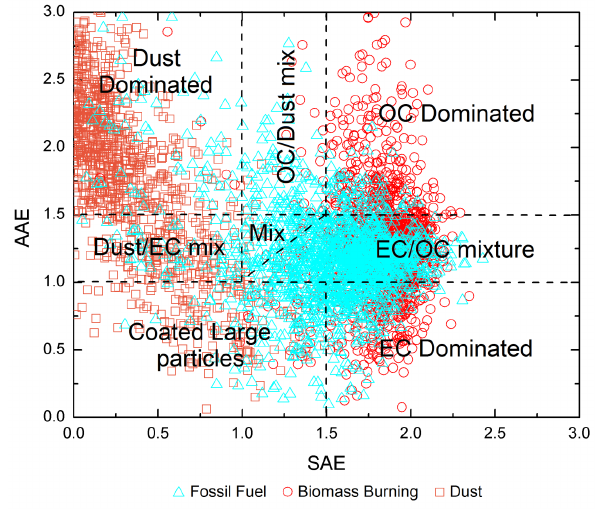
Fig. 2. Division of the Absorption Ångström Exponent vs. Scat- Figure 2. Division of the Absorption Ångström Exponent vs. Scattering Ångström Exponent 3 tering Ångström Exponent space, the Ångström matrix, overlapped space, the Ångström matrix, overlapped with the AERONET measurements from stations with a 4 with the AERONET measurements from stations with a dominant dominant sources (fossil fuel in cyan triangles, biomass burning in red circles or dust in orange 5 sources (fossil fuel in cyan triangles, biomass burning in red circles squares). 6 or dust in orange